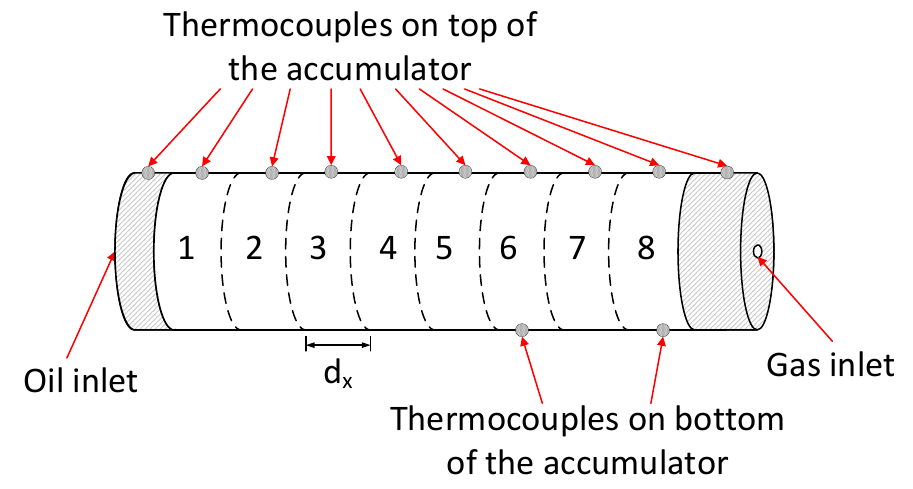
Figure 6. Placement of the thermocouples attached to the accumulator